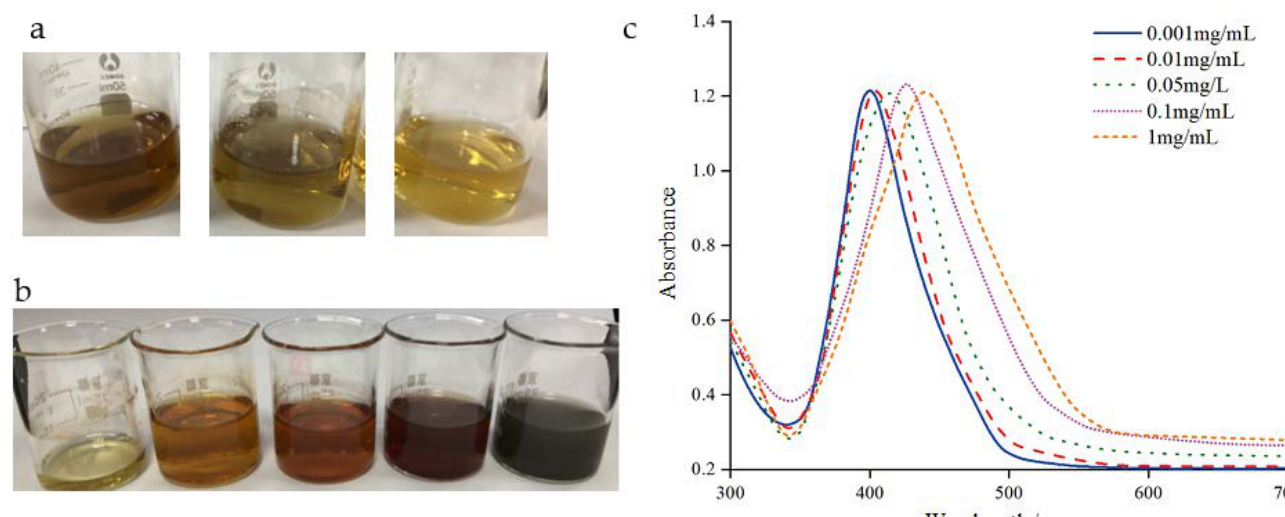
Figure 3. ( a ) Images of AgNPs solutions prepared by different capping agents: PVP, LA and SC (from left to right); ( b ) images; and ( c ) UV-vis spectrograms of AgNPs solutions prepared at different concentrations of silver nanoparticles using PVP as capping agent and NaNH 4 and SC as reducing agents: 0.001 mg/mL, 0.01 mg/mL, 0.05 mg/mL, 0.1 mg/mL and 1 mg/L (from left to right).